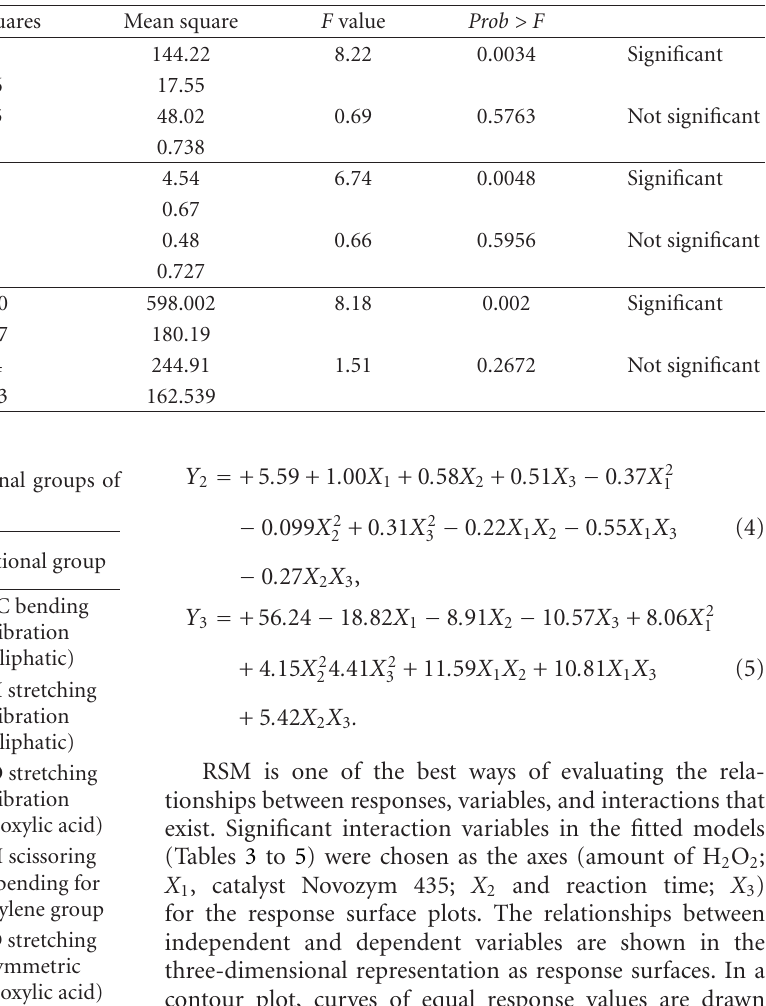
Table 6: Analysis of variance (ANOVA) for all the responses of MEOA.